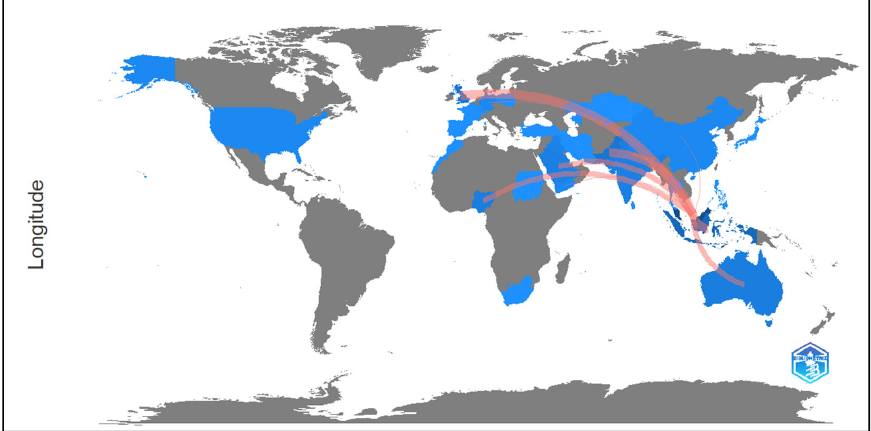
Figure 4. Country collaboration map.